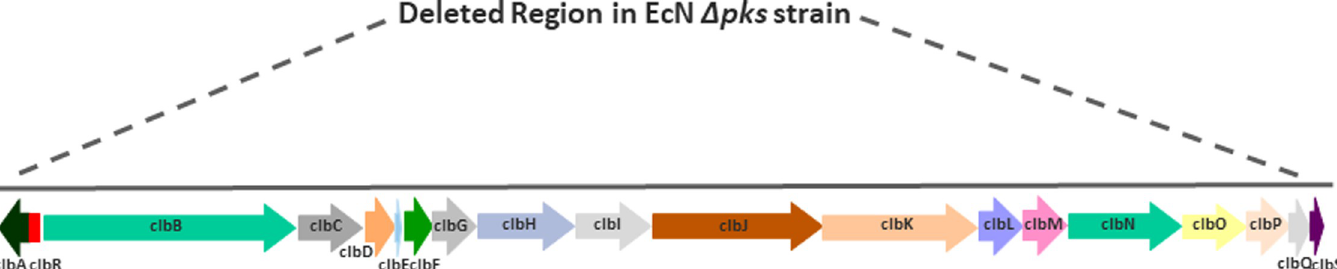
Fig 1. Schematic of an intact pks island coding for colibactin. This cluster consists of 19 genes starting with clbA and ending with clbS . The region of the pks island deleted is shown by dashed lines.